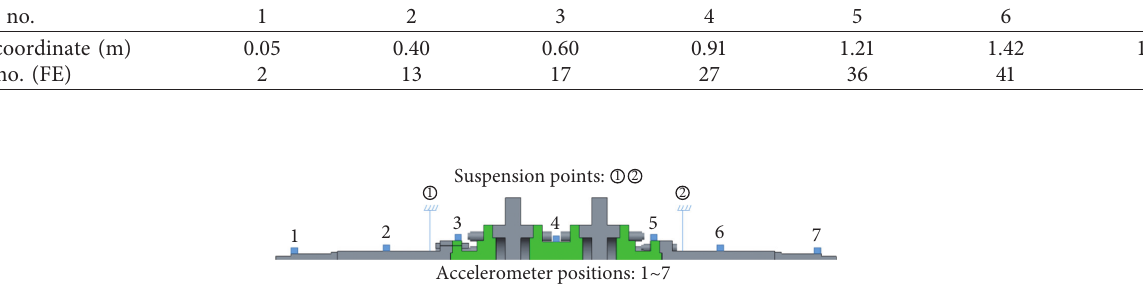
Accelerometer 3